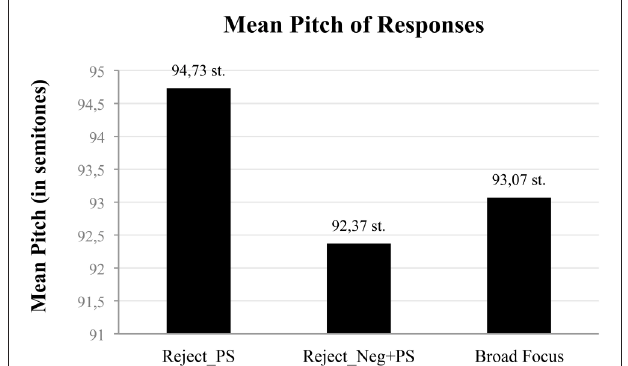
FIGURE 4 | Percentage of head movements (y-axis) of (1) Reject responses to negative questions/assertions produced with a positive sentence (left columns), (2) Reject responses to negative questions/assertions produced with a negative particle followed by a positive sentence (middle columns) and (3) Broad Focus responses (right columns). Results are separated by head movement type, e.g., Head Nods (black columns) and Head Shakes (gray